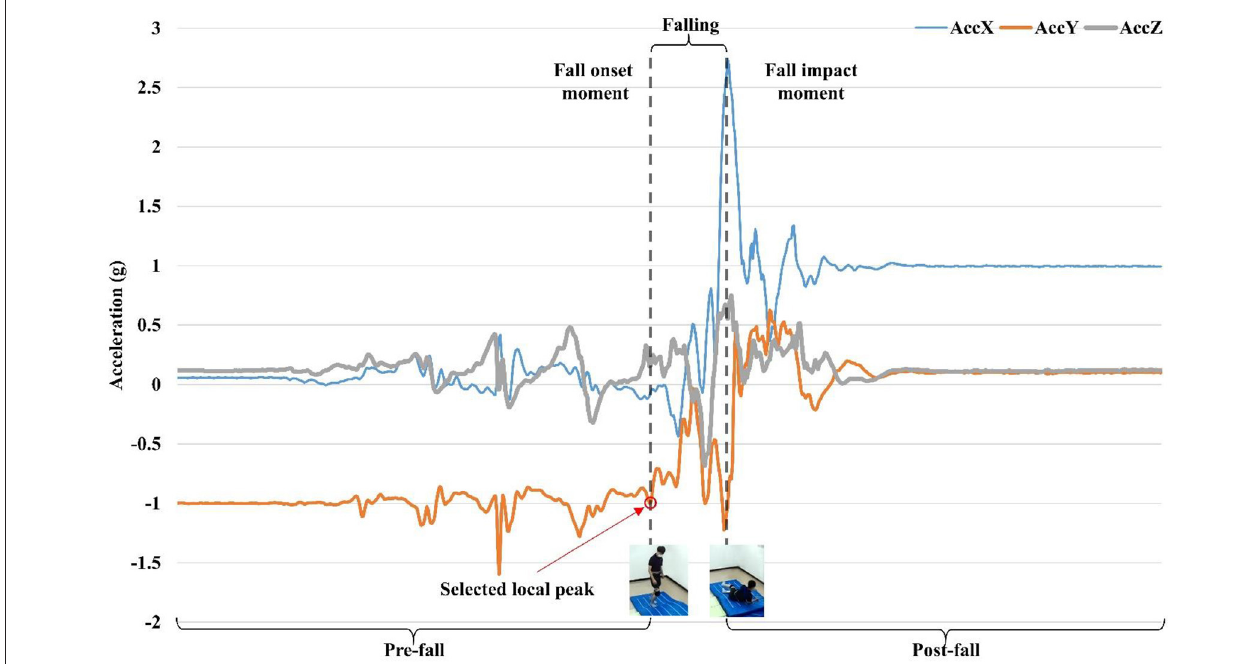
FIGURE 4 | Illustration of fall time labeling during a fall event based on the integrated motion video.